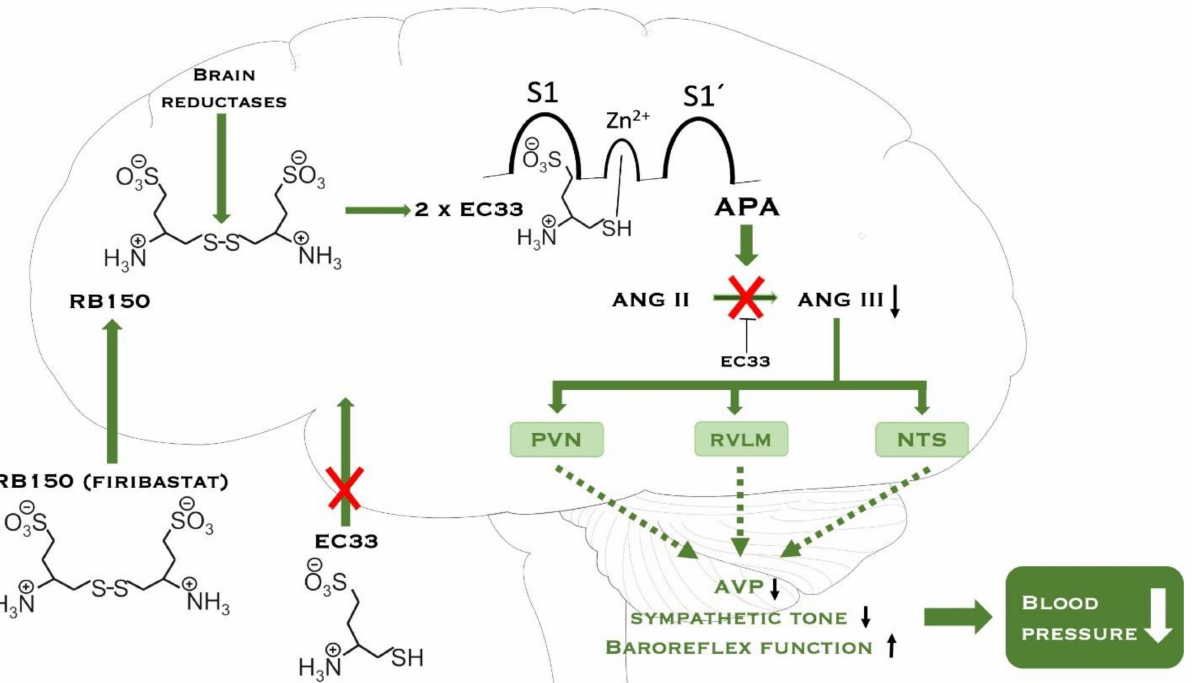
Figure 2. The prodrug RB150 (firibastat) can cross the blood–brain barrier after oral administration because of the disulfide bridge. RB150 consists of 2 EC33 molecules. EC33 cannot cross the blood– brain barrier. When RB150 has entered the brain, two active molecules of EC33 are released by brain reductases. The active EC33 molecules binds to the active site of aminopeptidase A (APA) and inhibits the formation of angiotensin III (Ang-III). Ang-III is the effector peptide. Normally Ang-III increases the blood pressure via 3 different mechanisms: (1) increases the release of arginine-vasopressin (AVP), (2) sympathetic nerve activation, and (3) inhibition of the baroreflex. When APA is inhibited, angiotensin II is not cleaved into Ang-III, which exerts a stimulatory action on the control of blood pressure in brain structures, resulting in decreased blood pressure. Abbreviations: aminopeptidase